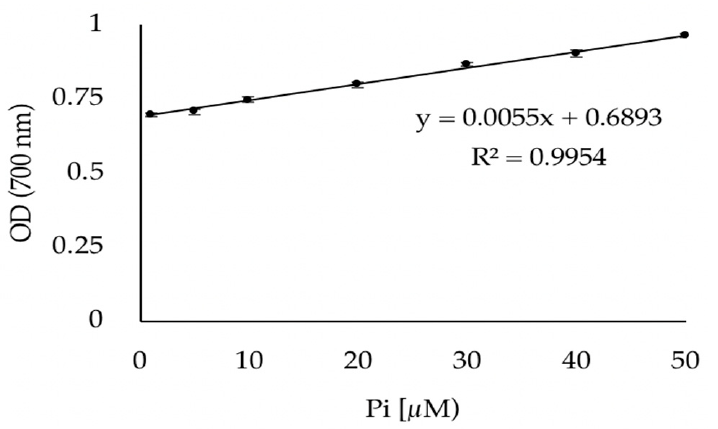
Figure 1. Linearity of the P i dosage. Standard P i solutions of 10 µM to 50 µM prepared in tris-HCl buffer (pH = 8.5; 50 mM). Incubation time: 10 min. λ = 700 nm. Error bars show the standard deviation obtained from experiments carried out in triplicate.